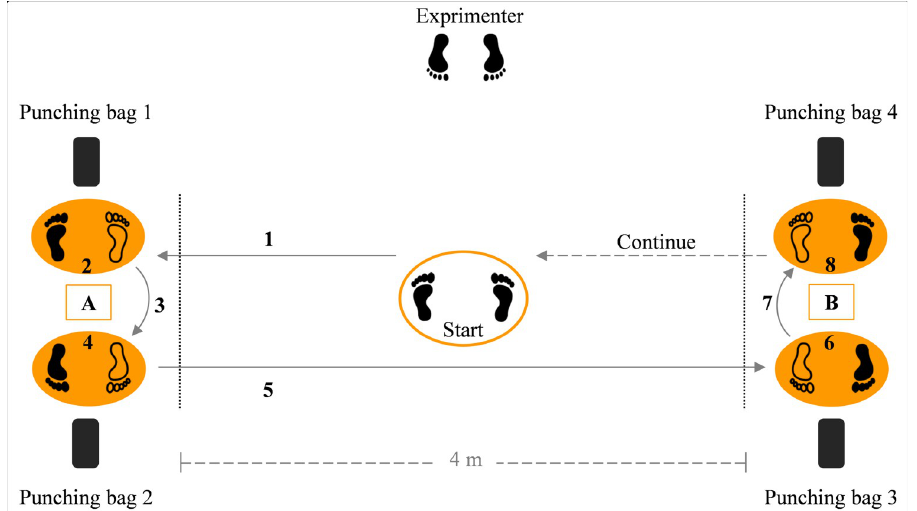
Fig 2. Taekwondo-specific aerobic-anaerobic-agility (TAAA) test. The test involves six 20-s (a total of 2 minutes) intervals of shuttle sprints between point A and B and performing roundhouse kicks at these points, with a 10-s